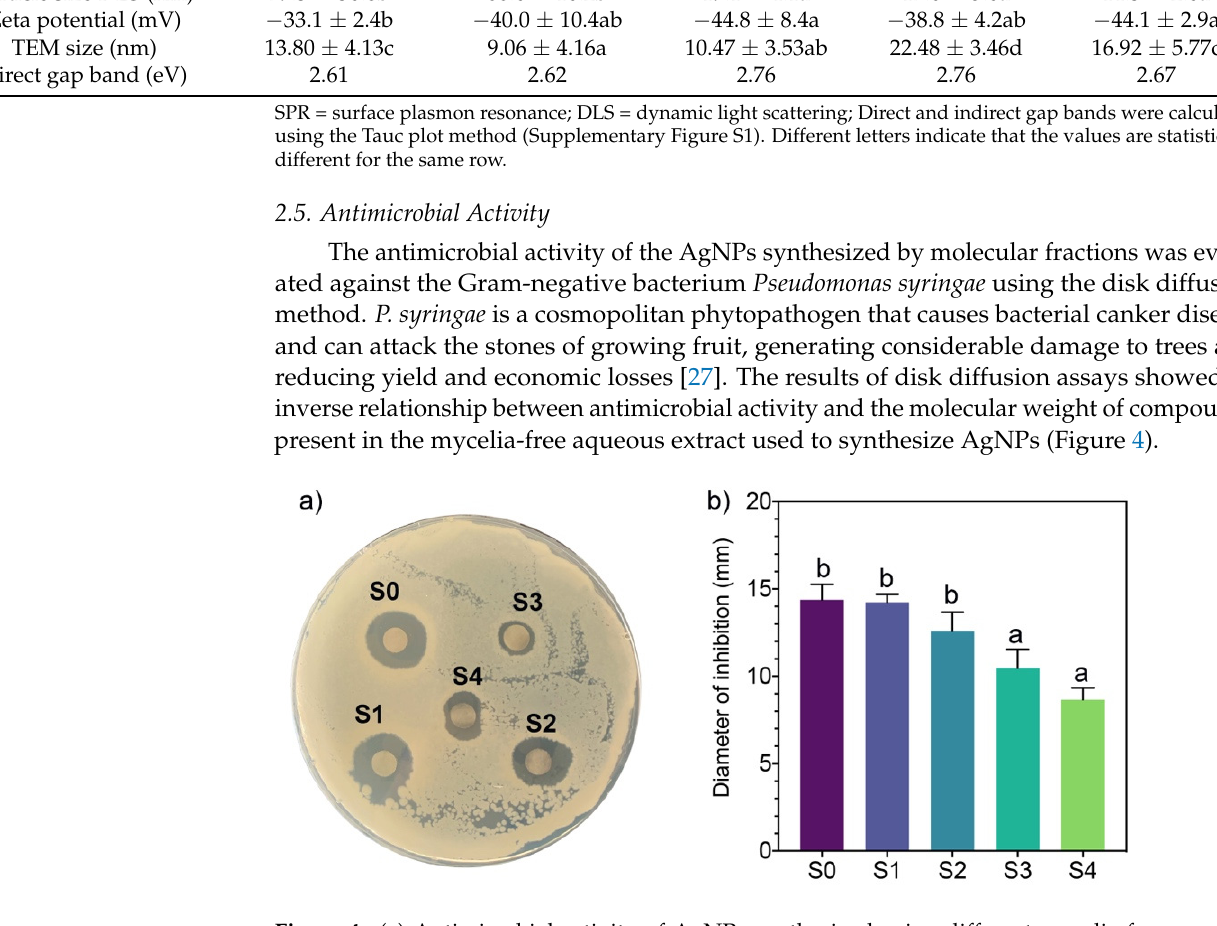
Figure 4. ( a ) Antimicrobial activity of AgNPs synthesized using different mycelia-free aqueous extract fractions by the method of paper disk diffusion. ( b ) Different letters indicate that the values are statistically different.